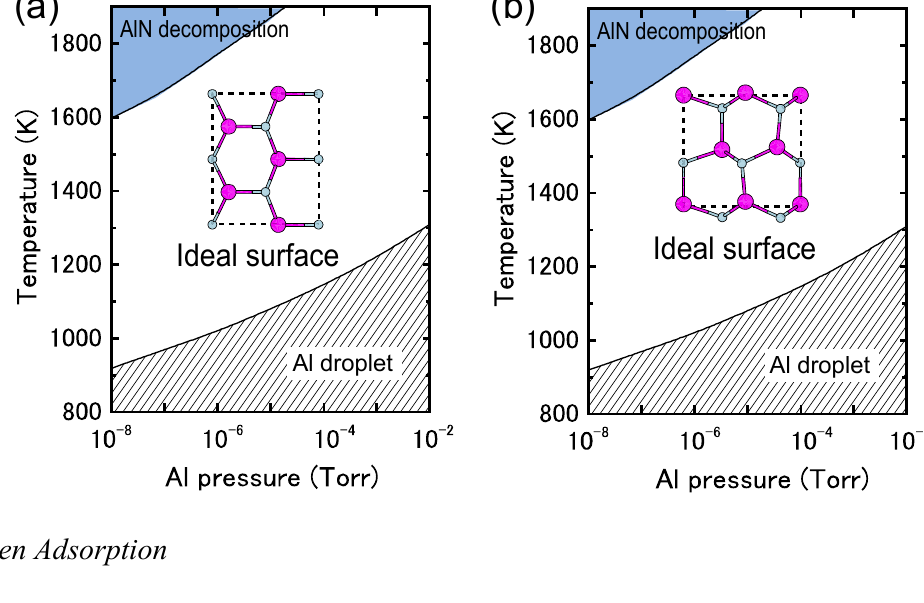
Figure 26. Calculated phase diagrams for nonpolar AlN surfaces with ( a ) (cid:4666)11(cid:3364)00(cid:4667) and ( b ) (cid:4666)112(cid:3364)0(cid:4667) orientations as a function of temperature and Al BEP. The